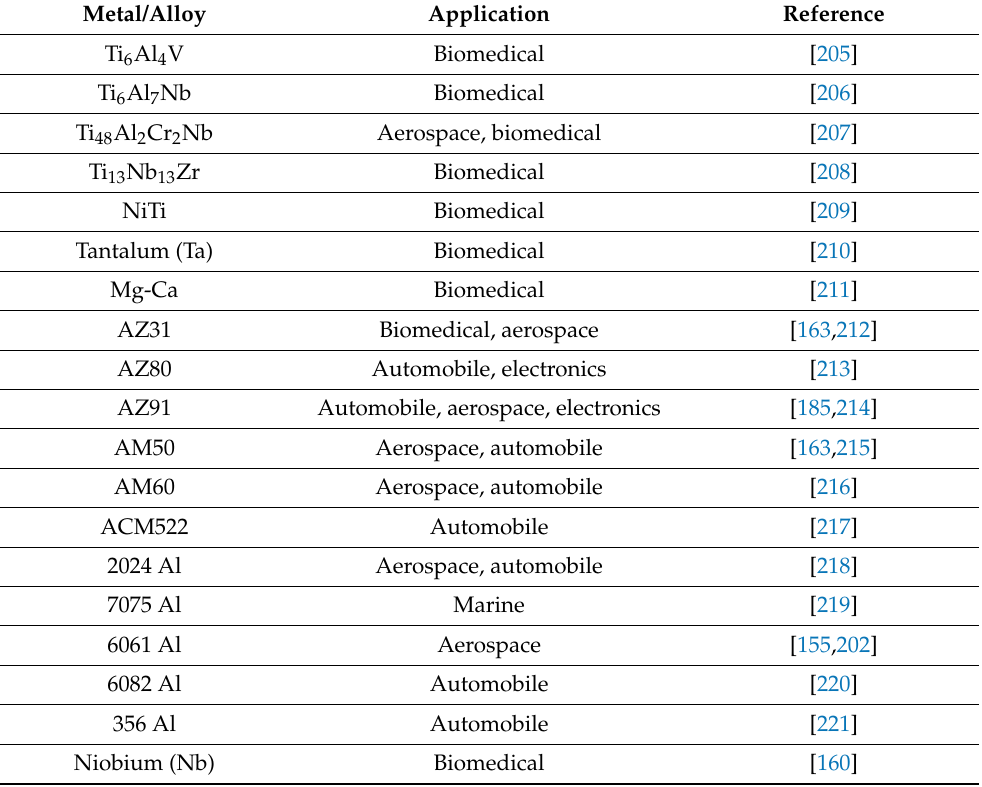
Table 4. Table highlighting applications of few alloys subjected to PEO